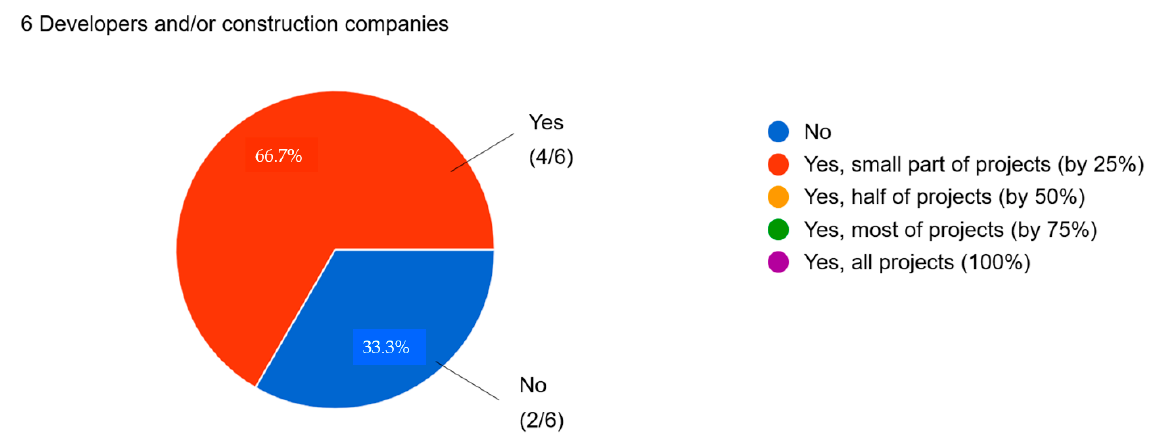
Figure 3. BIM adoption in developers and/or construction companies.